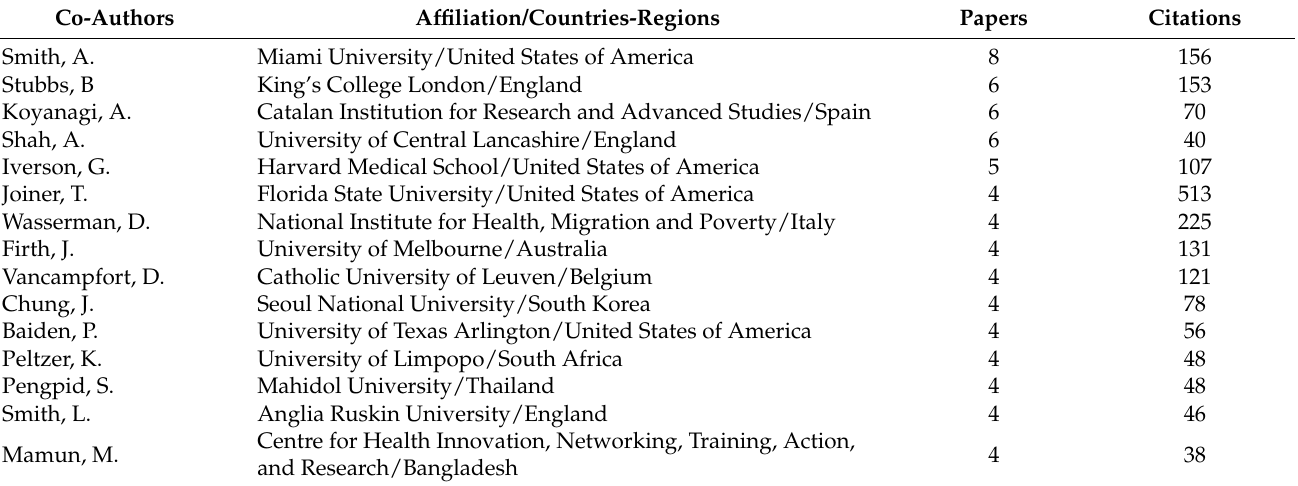
Table 4. Most prominent co-authors on Suicide and Physical